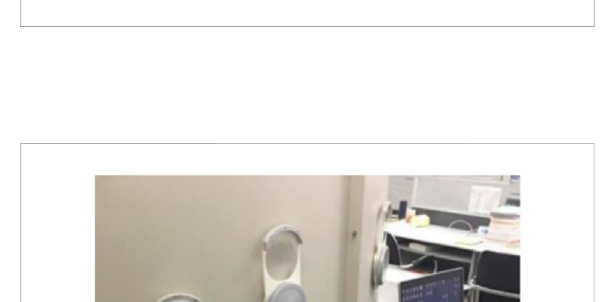
FIGURE 9 Physical illustration of emitter end.